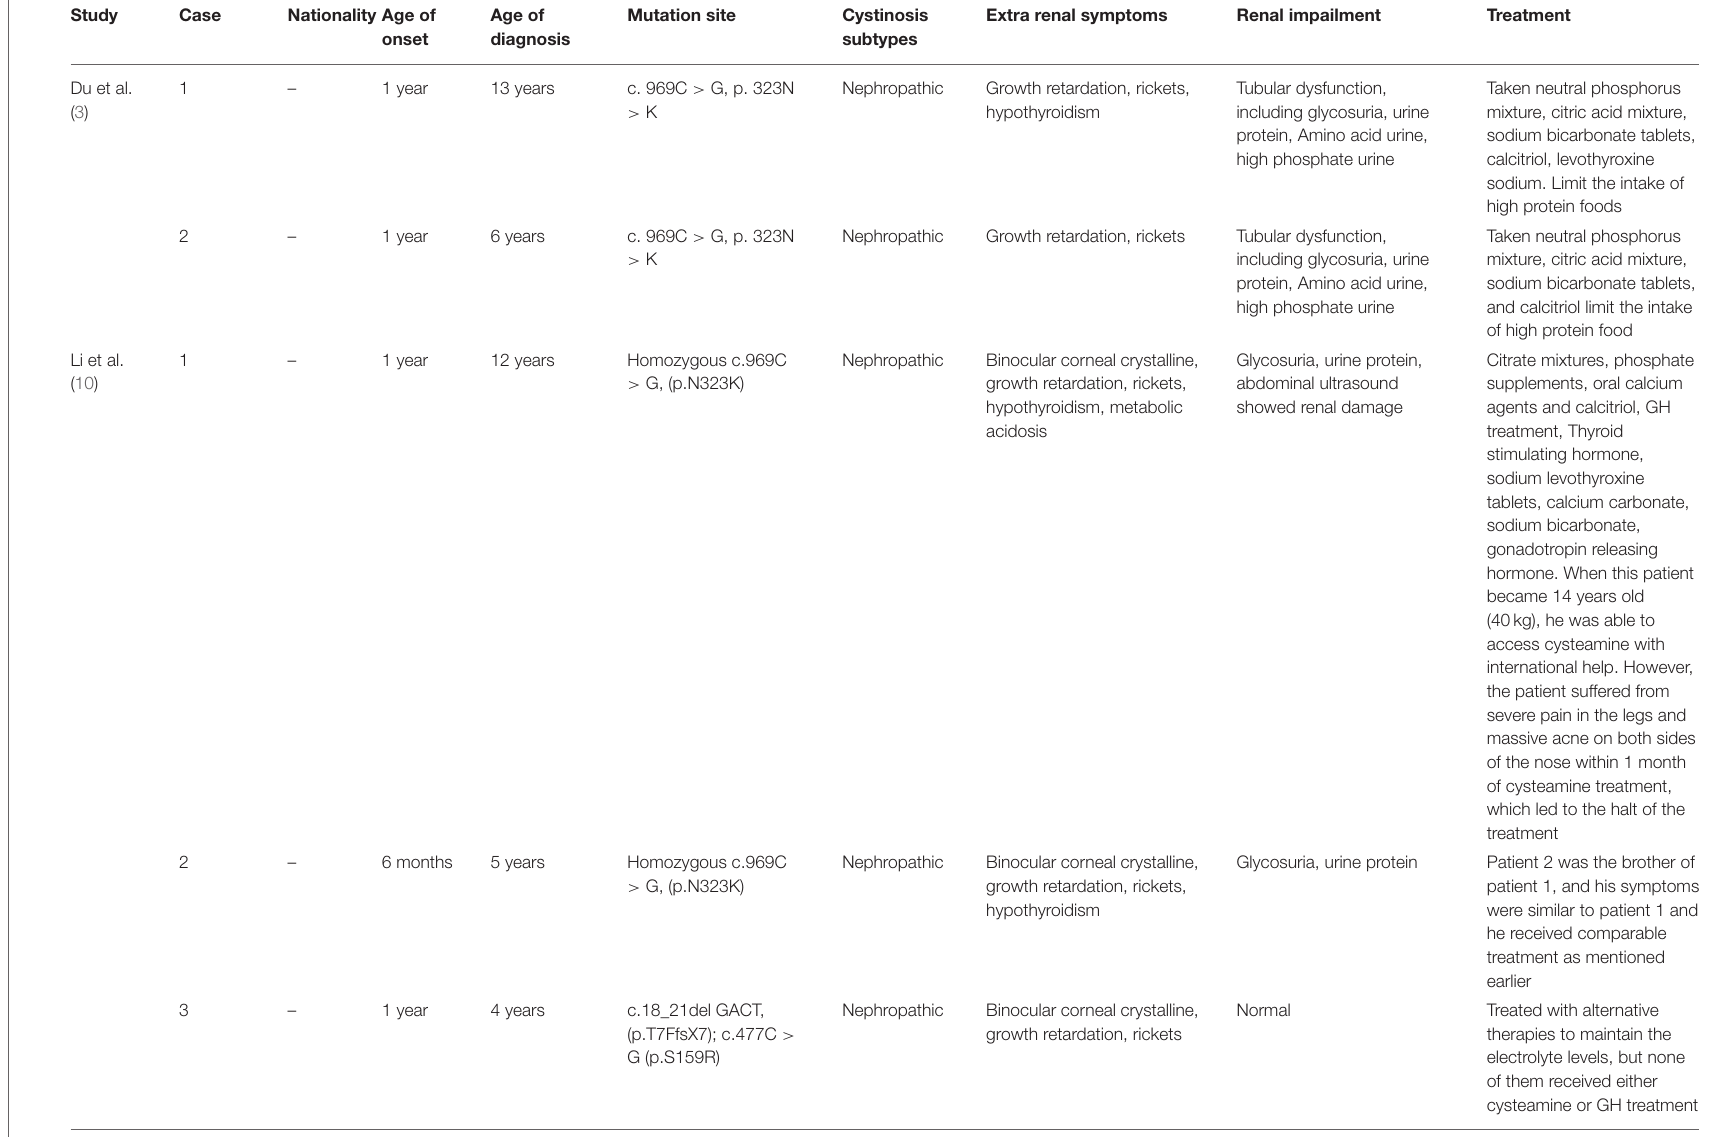
TABLE 1 | Clinical and molecular characteristics of Chinese patients with cystinosis.